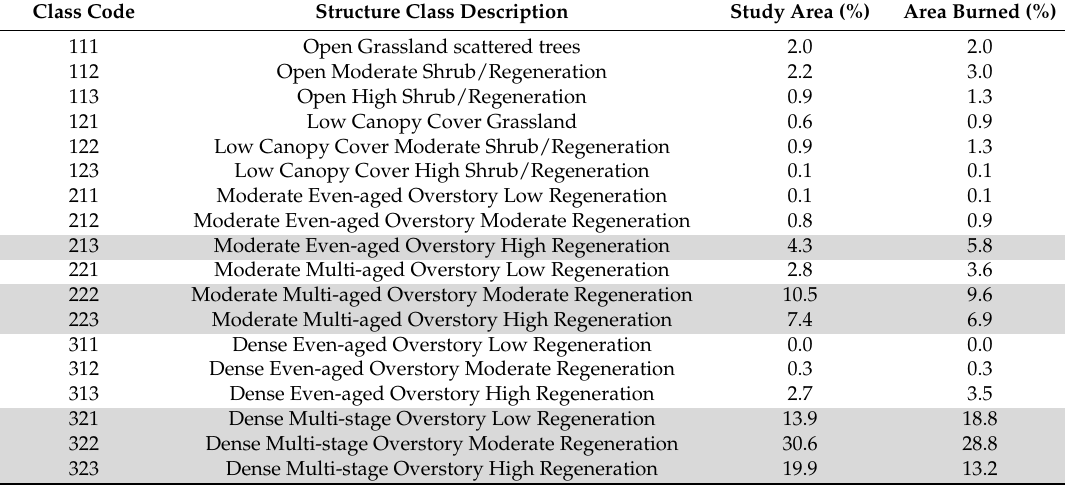
Table 2. The six most common classes (in grey) that occur on the North Rim cover 87% of the study area, the remaining eleven classes cover the other 13%. Those same six structure classes populate the majority of the area that burned in the